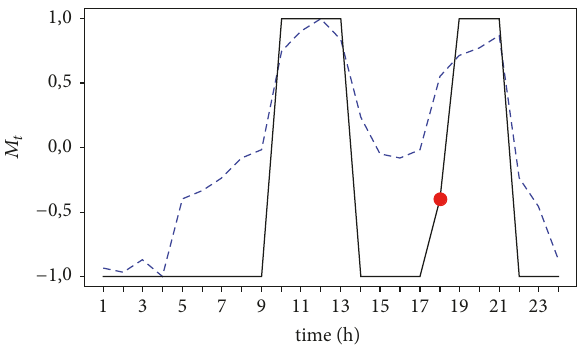
Figure 3: Resulting per-bus magnetisations. Blue dotted line shows the values for the normalised RTEM prices 𝜆 sents a situation where the discrete spin system is unable to comply with the electrical constraint by flipping spin